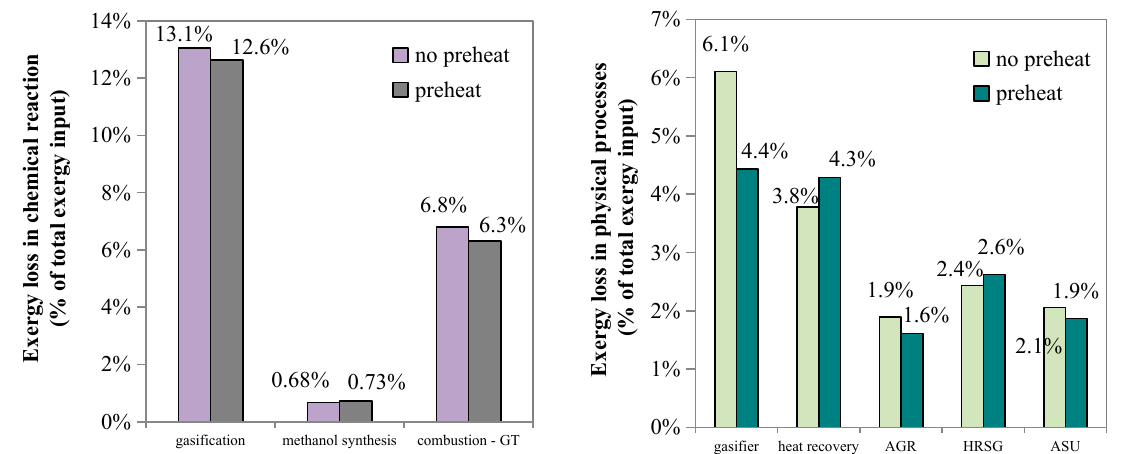
Figure 6. Exergy losses in chemical reactions and physical processes with and without slurry pre-heating.